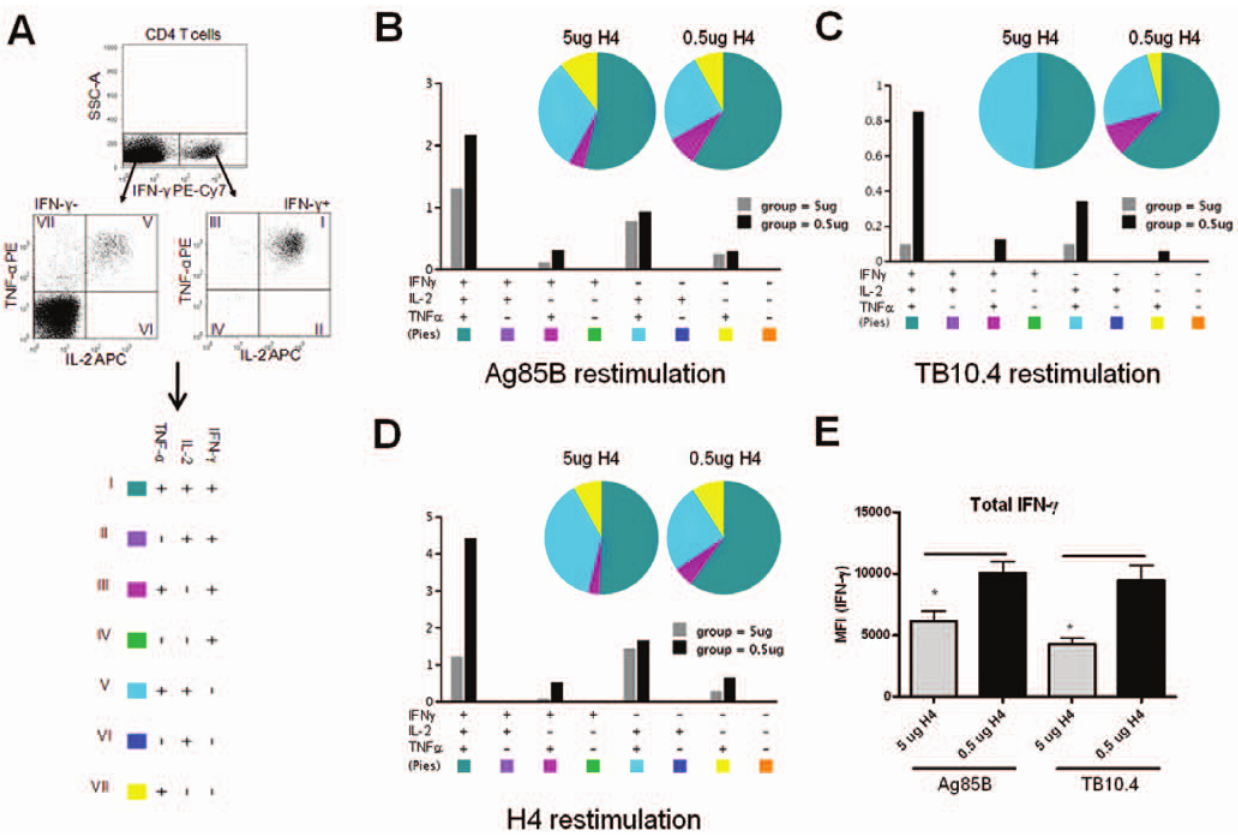
Figure 3. Ag85B and TB10.4 specific T cells are polyfunctional. (A). Cytokine profiles of H4 specific CD4 T cells were determined by first dividing the CD4 T cells into IFN- c positive ( + ) or IFN- c negative (-) cells. Both the IFN- c + and IFN- c 2 cells were analyzed with respect to the production of TNF- a and IL-2. The numbers in the quadrant gates of the plots denominates each distinct population based on their cytokine production and is color coded as shown. (B–D) The pie charts are grouped after vaccination dose and colour coded according to the cytokine production profile and summarizes the fractions of the CD4 + T cell response (out of the antigen specific CD4 T cells) that are positive for a given cytokine production profile. Every possible combination of cytokines is shown on the x-axis of the bar chart and the percentage of Ag85B, TB10.4 or Ag85B-TB10.4 (H4) specific CD4 + T cells expressing any combination of cytokines is given for each immunization group. The antigen used for in vitro stimulation of the PBMC’s is indicated. No responses were seen in the CD8 + T cell subset. (E) The mean fluorescence intensity (MFI) of IFN- c in the subpopulations expressing this cytokine from animals vaccinated with either 0.5 m g H4 or 5 m g H4. Results are representative of two independent experiments.